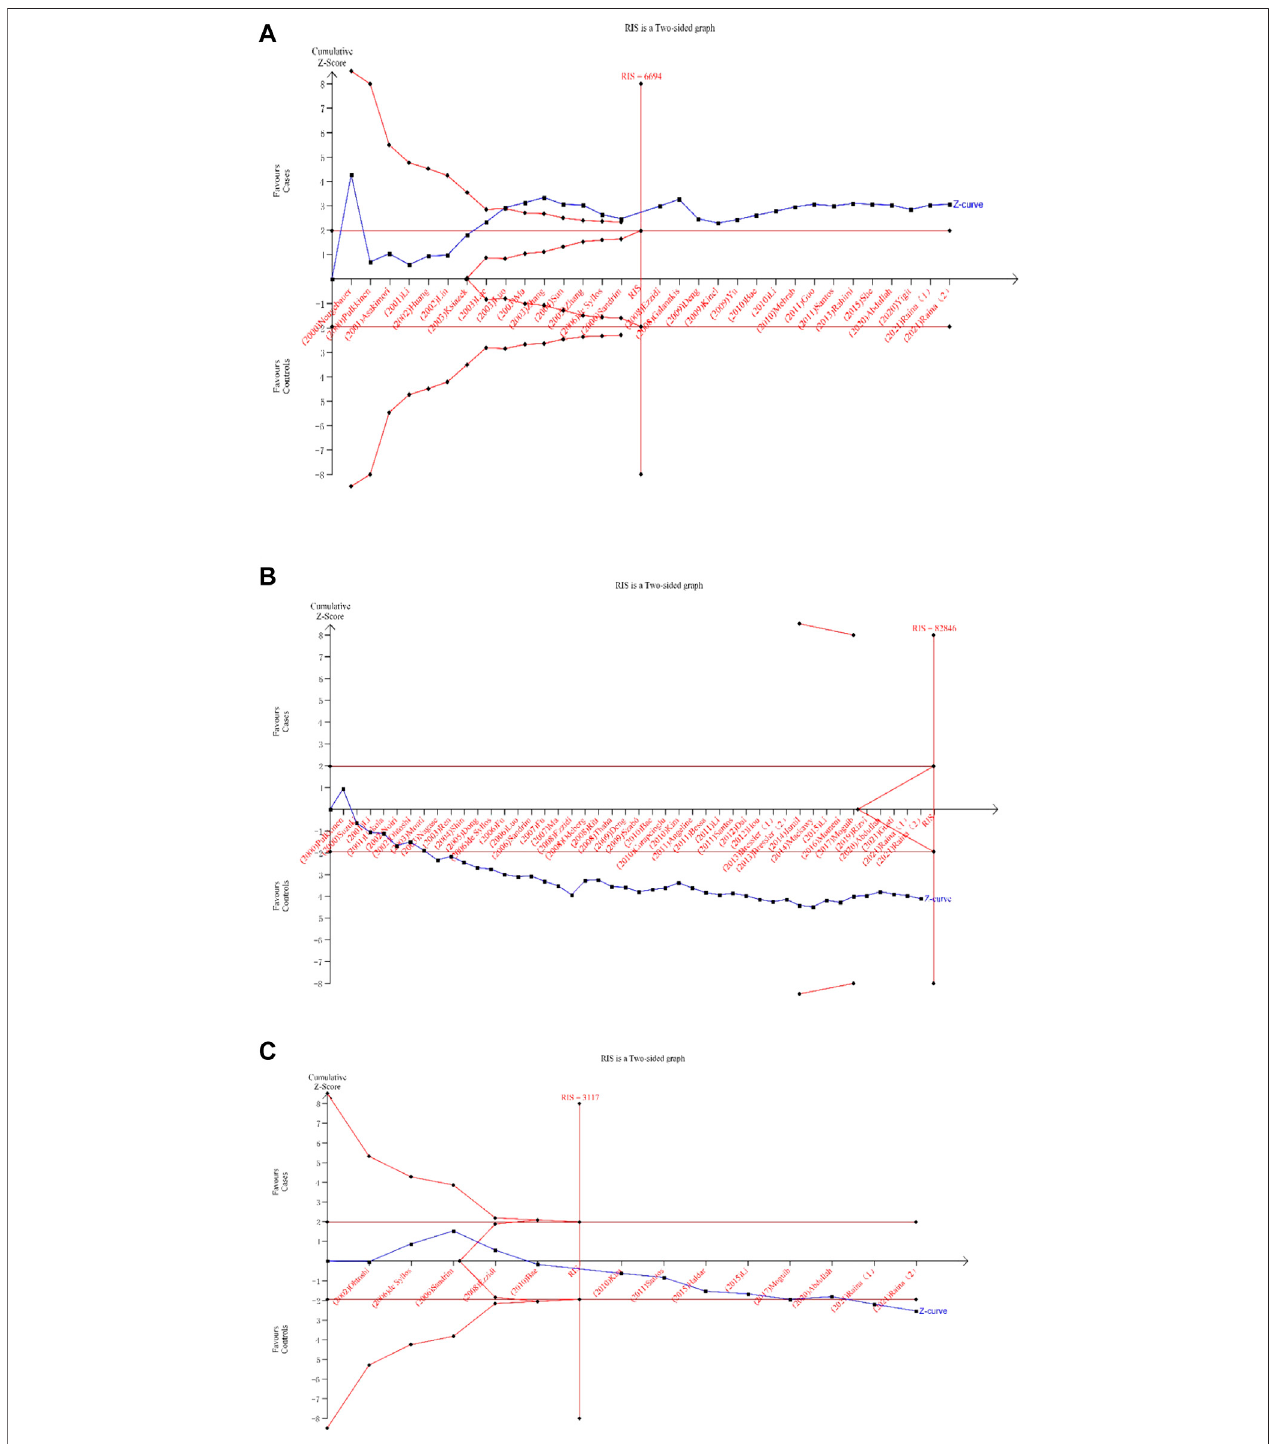
FIGURE 6 | Trial sequential analysis for the eNOS polymorphisms under dominant gene model [ (A) : (bb + ab) vs. aa; (B) (TT + GT) vs. GG; (C) (CC + TC) vsTT)].